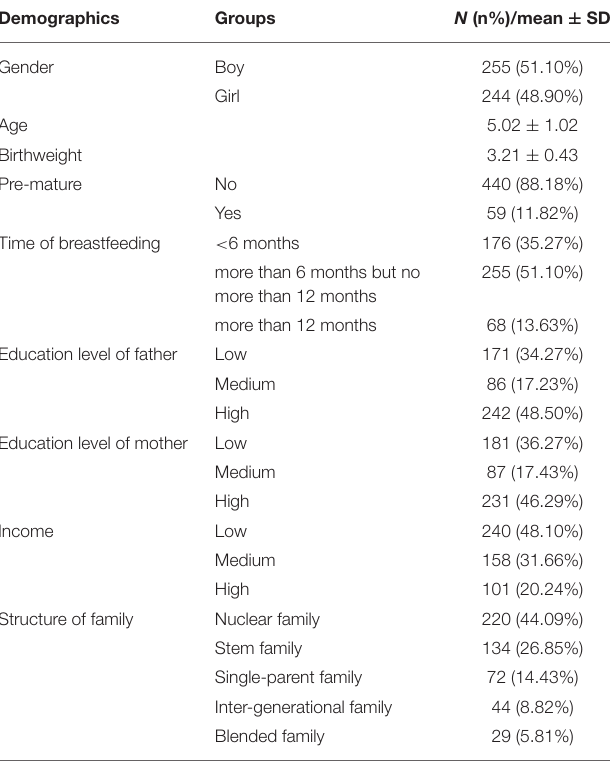
TABLE 1 | Demographic data of pre-schoolers in the study ( N =